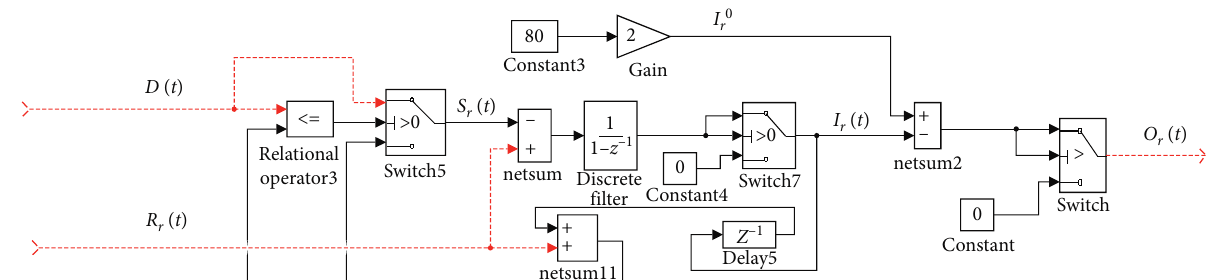
Figure 2: The block diagram of the retailer from the local decision